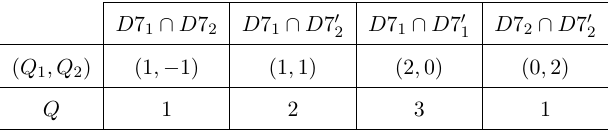
Table 3 . U(1) charges for charge 3 (II) models in type IIB.